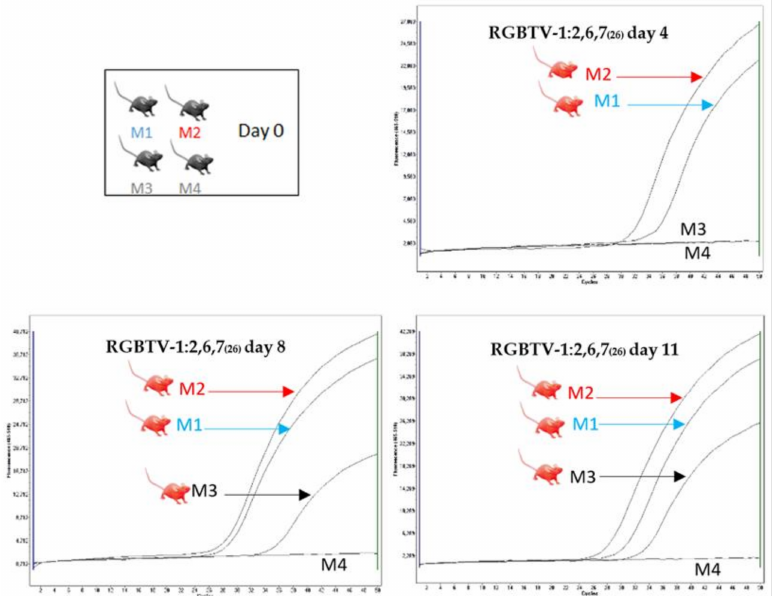
Figure 8. Real-time RT-PCR amplification curves of RNA extracts from blood samples of mice inoculated with BTV-1:2,6,7 (26) . On day 4 both inoculated mice were positive by real-time RT-PCR. On day 8 and 11 one in-contact mouse was positive for BTV